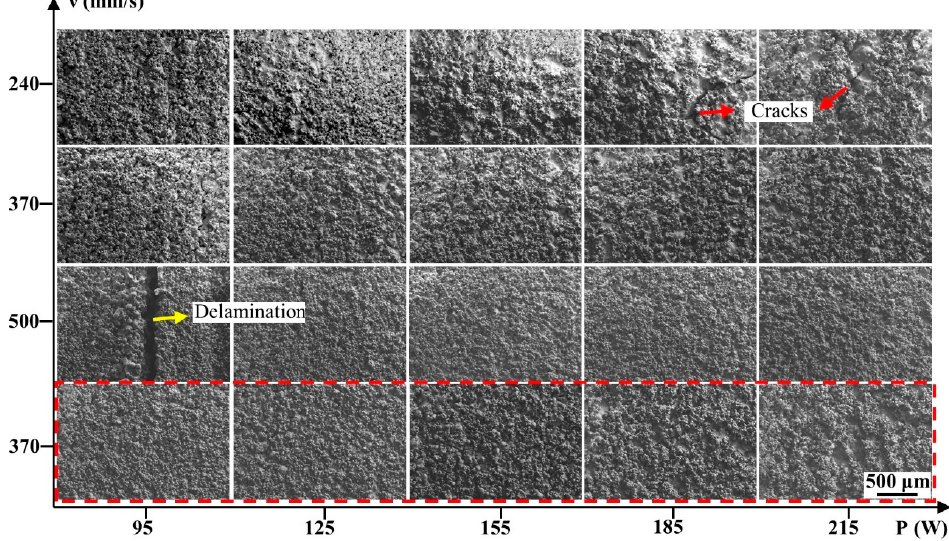
Figure 6. The front surface morphology of the specimens formed at different process parameters: The samples in the red dashed box were formed under the Scan II strategy.